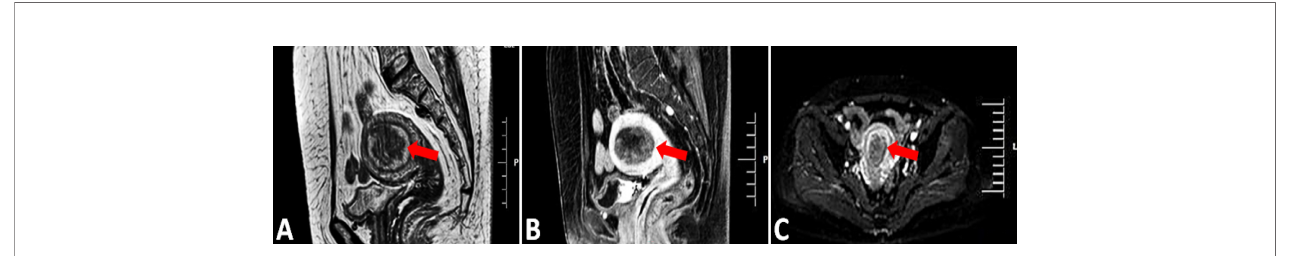
FIGURE 2 | MRI, Magnetic resonance imaging. (A, B) Sagittal T2-weighted and T1 enhancement image showing the 5.2CM*3.5CM mass in the uterine cavity, the abnormal signal affected more than 1/2 of the myometrium (arrow). (C) Axial diffusion weighted image showing hyperintense endometrium (red